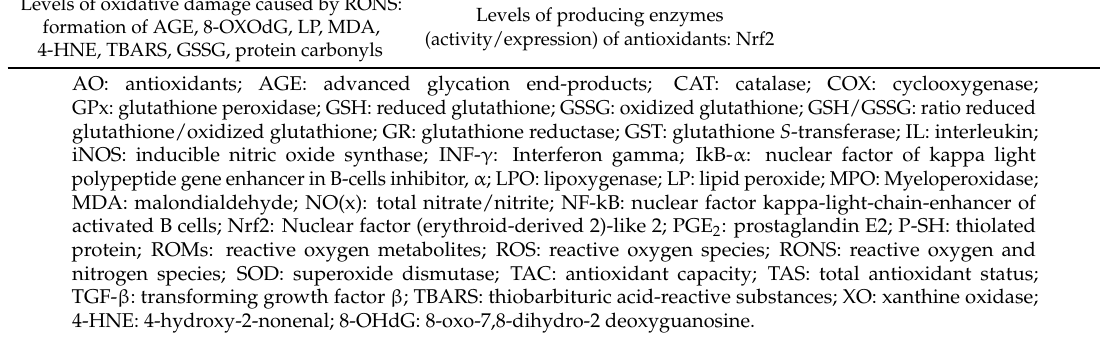
Table 1. Markers of antioxidant defense, oxidative damage and inflammation. Synthesis of RONS or Damage by Them, Forming ROMs